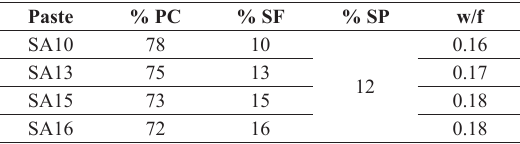
Table 3. Mixtures chosen for the experimental analysis.